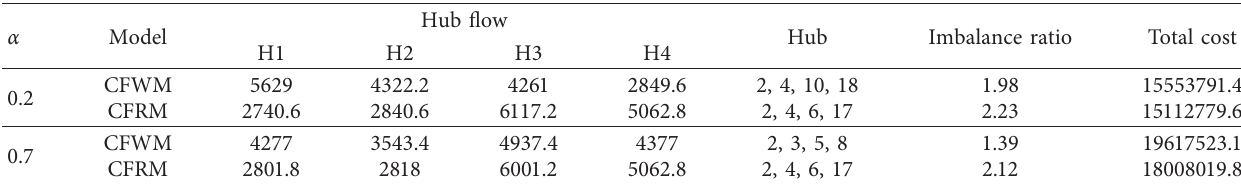
Table 6: Impact of scale benefit discount α on model results.